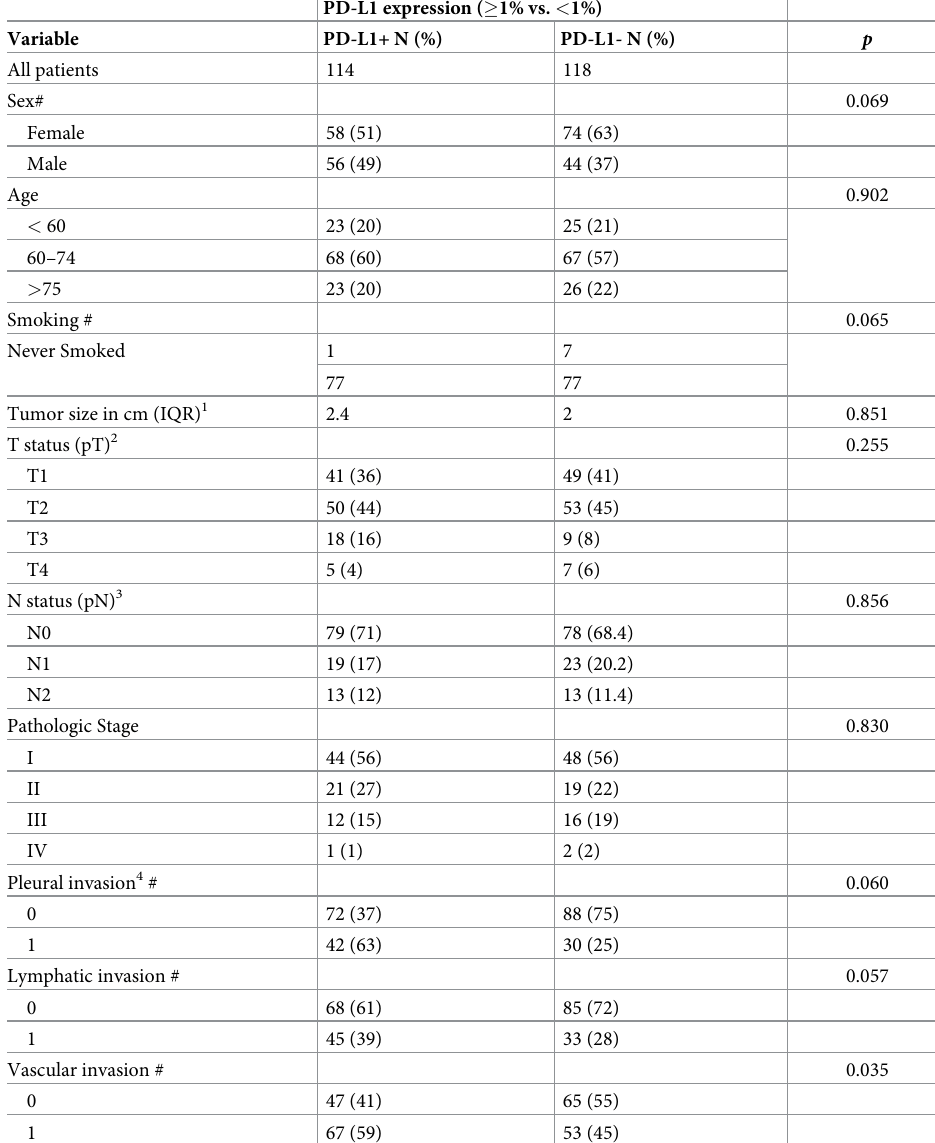
Table 6. Clinicopathological characteristics and molecular alterations of lung adenocarcinoma patients stratified by PD-L1 expression on tumor